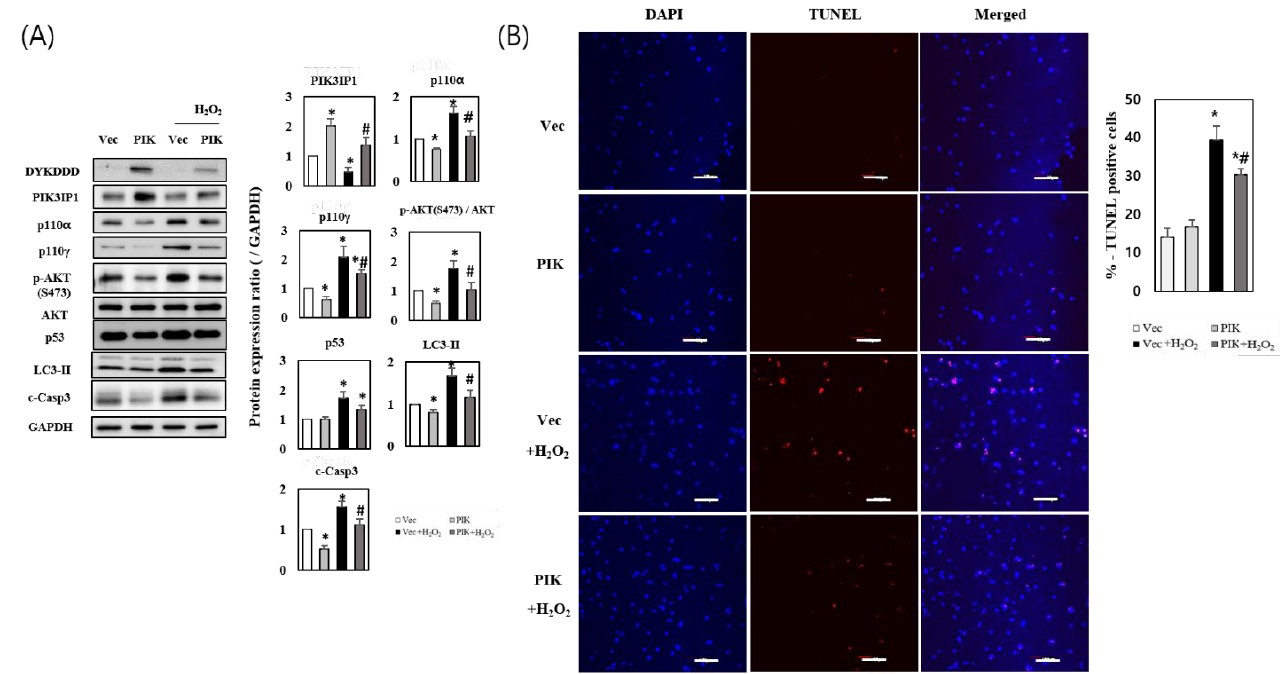
nuclei staining. The scale bar represents 200 μm. The graph on the right shows the significantly